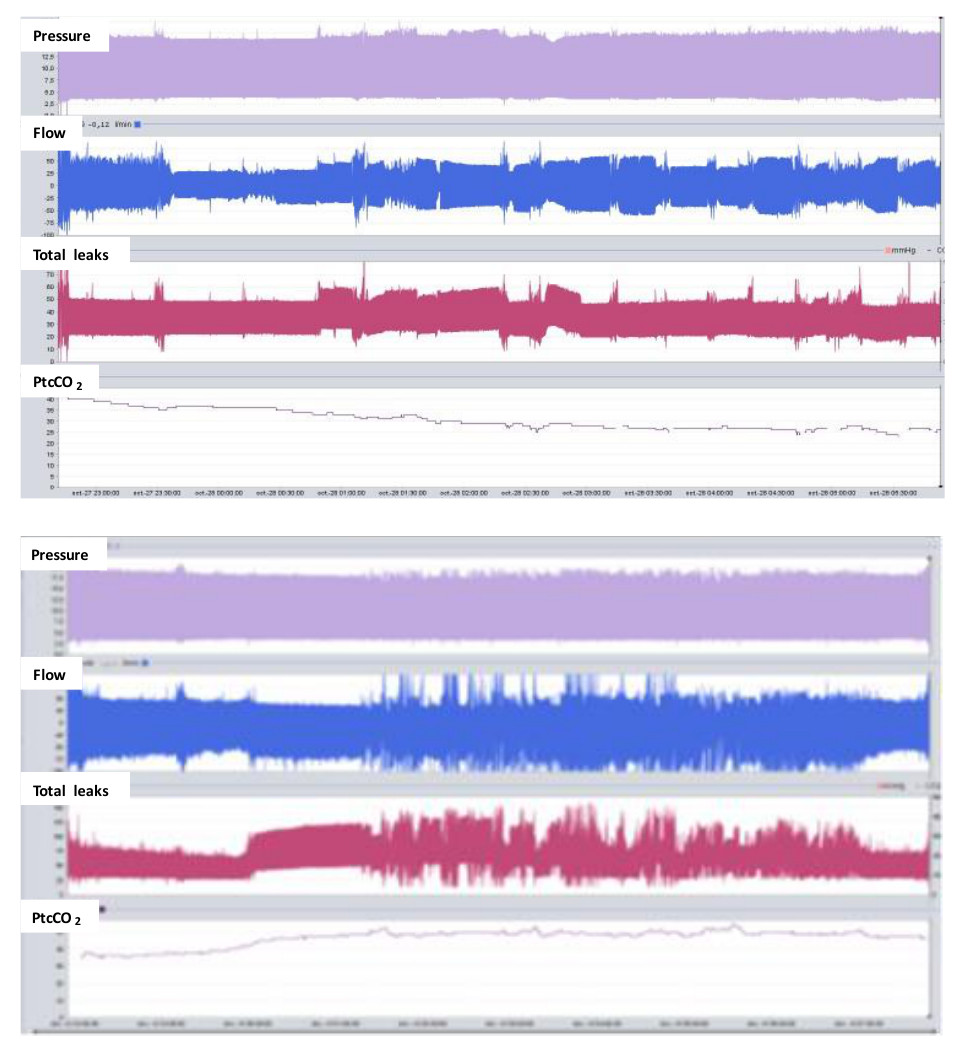
Figure 7. Nocturnal transcutaneous capnography using a device connected to the ventilator. Upper panel shows the full night recording of pressure, flow, total leaks, and raw measurement of PtcCO 2 . PtcCO 2 decreases along the night from 40 to 30 mm Hg, suggesting hyperventilation. Lower panel shows an increased PtcCO 2 along the night from 40 to 52 mm Hg, suggesting alveolar hypoventilation. However, there is a concomitant increase in total leaks, which means that nonintentional leaks are the main cause of PtcCO 2 increase.